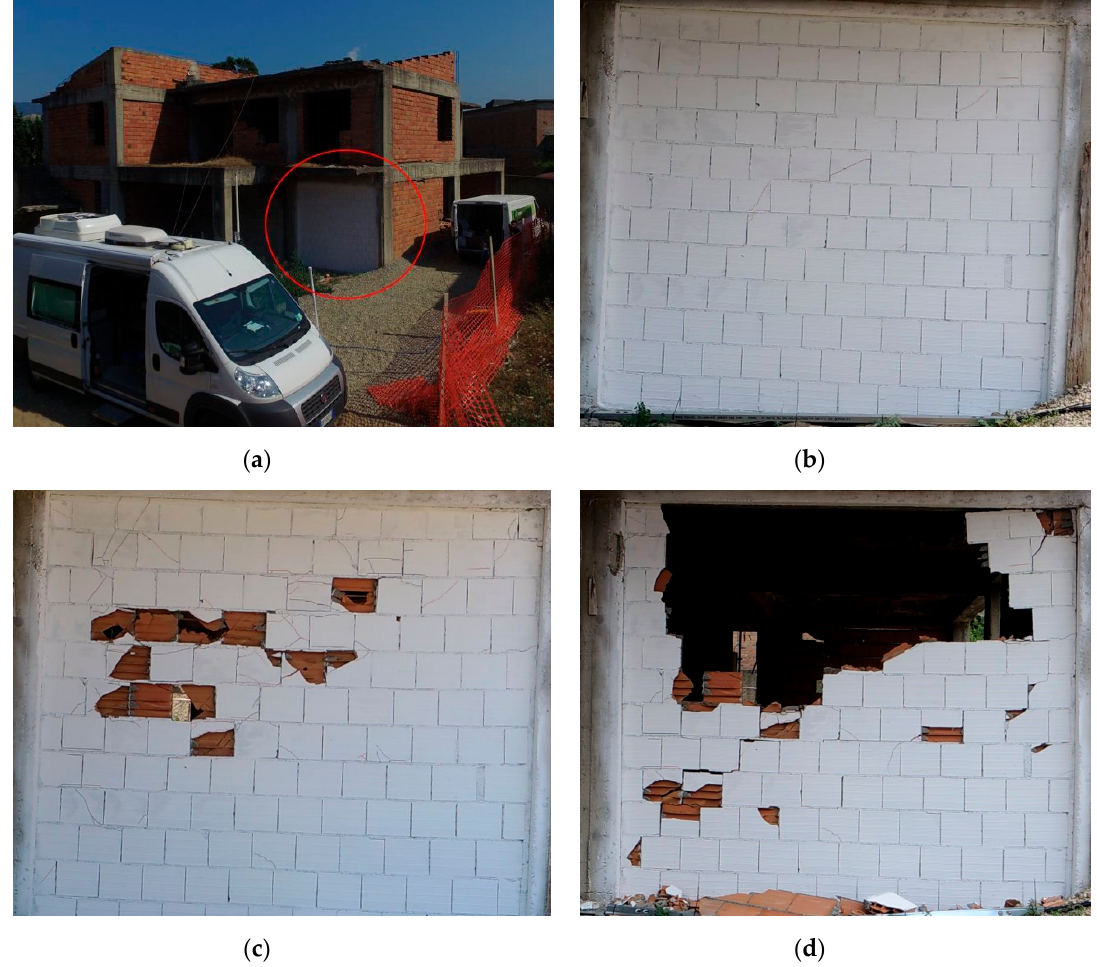
Figure 12. Infill panel i2 ( a ), cracking pattern at: run #2—4.3 mm / 0.12% ( b ), run #5—12.9 mm / 0.35% ( c ), run #8—52.6 mm / 1.42% ( d